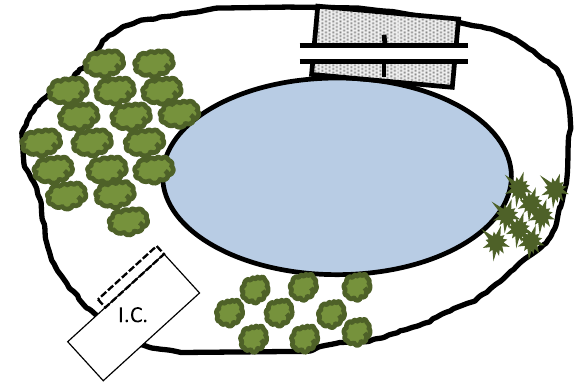
FIG. 5. School yard with two narrow bridges, in series, over a ditch.